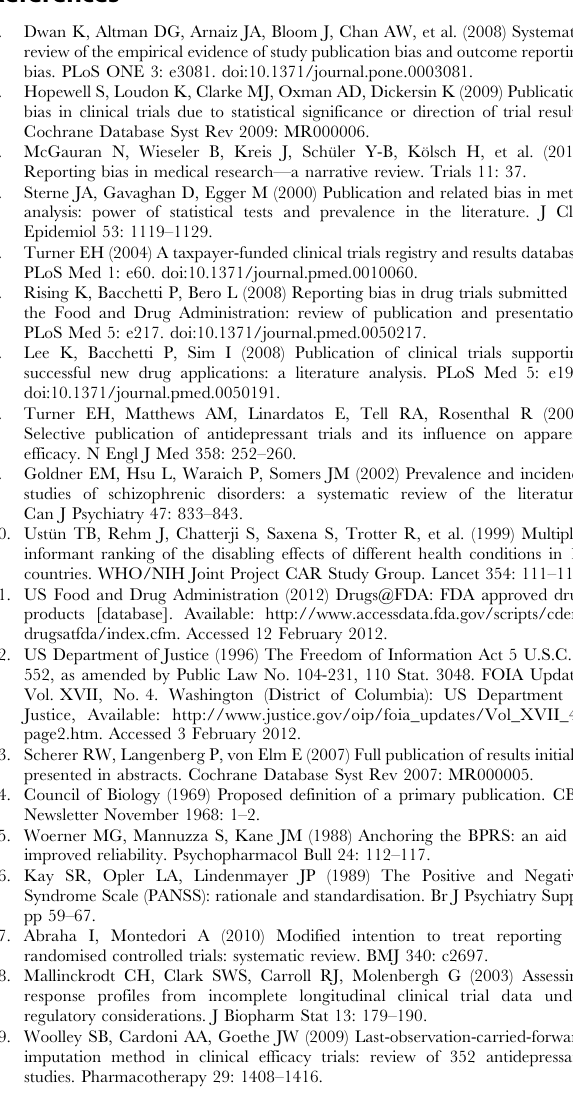
Table S1 Two-by-two tables of trial outcome according to the FDA versus publication status. Table S2 Meta-analysis of clinical trial data from FDA drug approval packages—output from statistical pro- gram Stata.